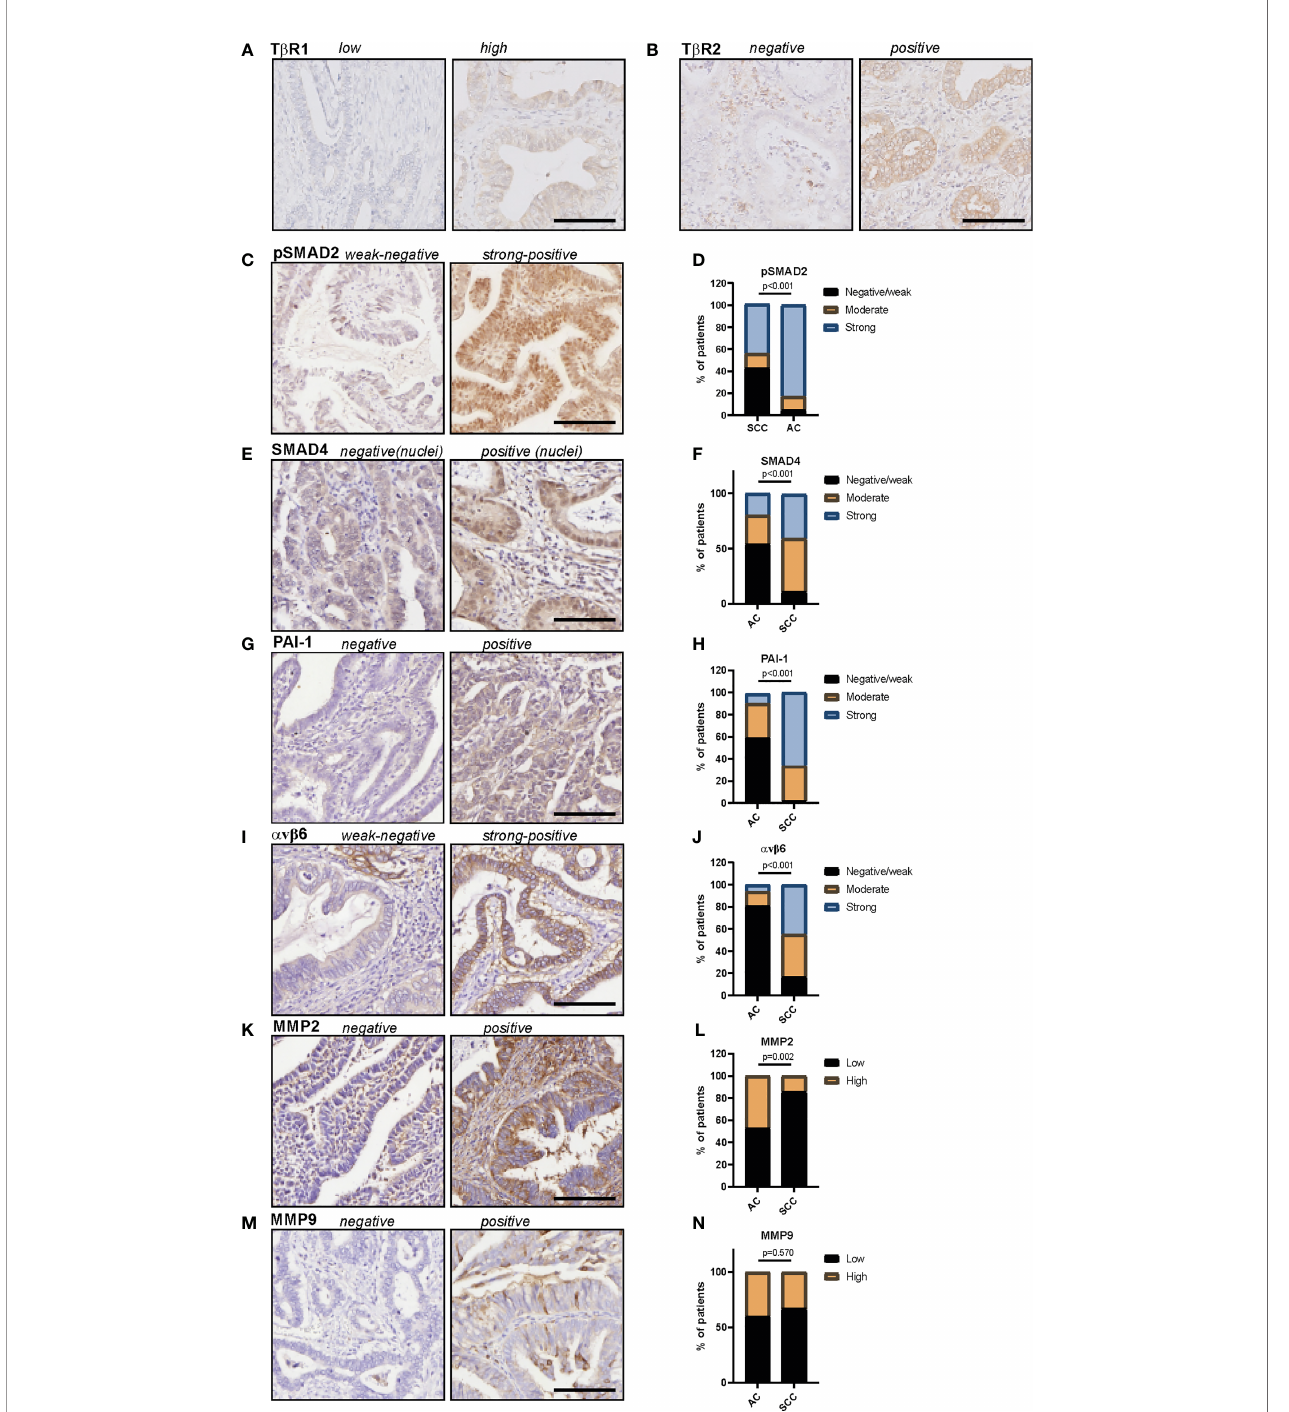
FIGURE 2 | Protein expression of T b R1, T b R2, pSMAD2, SMAD4, PAI-1, a v b 6 and MMP2 and MMP9 in cervical adenocarcinomas. (A) example of T b R1 staining, (B) example of T b R2 staining, (C) example of pSMAD2 staining, (D) pSMAD2 staining in AC and SCC samples. (E) Example of SMAD4 staining, (F) SMAD4 staining in AC and SCC samples. (G) Example of PAI-1 staining, (H) PAI-1 staining in AC and SCC samples. (I) Example of a v b 6 staining, (J) a v b 6 staining in AC and SCC samples. (K) Example of MMP2 staining, (L) MMP2 staining in AC and SCC samples. (M) Example of MMP9 staining, (N) MMP9 staining in AC and SCC samples. All protein expression scores can be found in Table 2 (AC) and Table 4 (SCC and AC). P values are calculated using Chi-squared test. AC, adenocarcinoma; SCC, squamous cell carcinoma. Scale bar represents 100 m